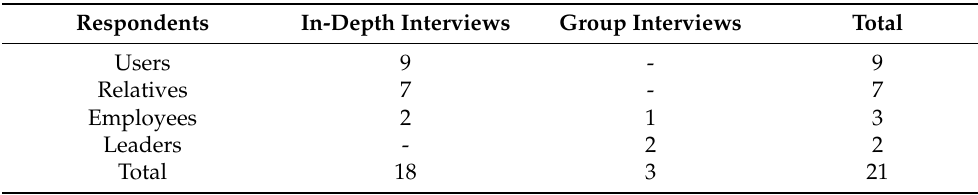
Table 2. Conducted interviews.